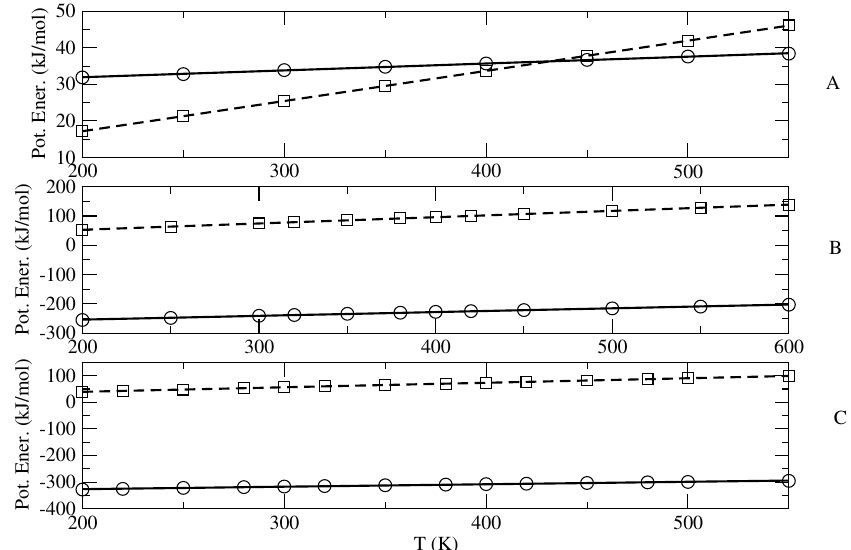
Figure 2. Plot of (cid:104)U pot , bending (cid:105) (squares) and (cid:104)U pot (cid:105) − (cid:104)U pot , bending (cid:105) (circles) as a function of the temperature, provided by the MD simulations of n-butane ( A ), BmimNTf 2 ( B ) and BmimPF 6 ( C ), as well as their quadratic and linear fittings (dashed and solid lines, respectively).